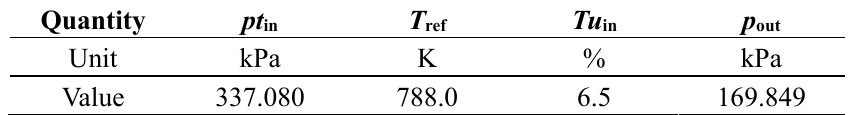
Table 1. Test condition parameters of main flow for the case of the turbine vane Mark II.